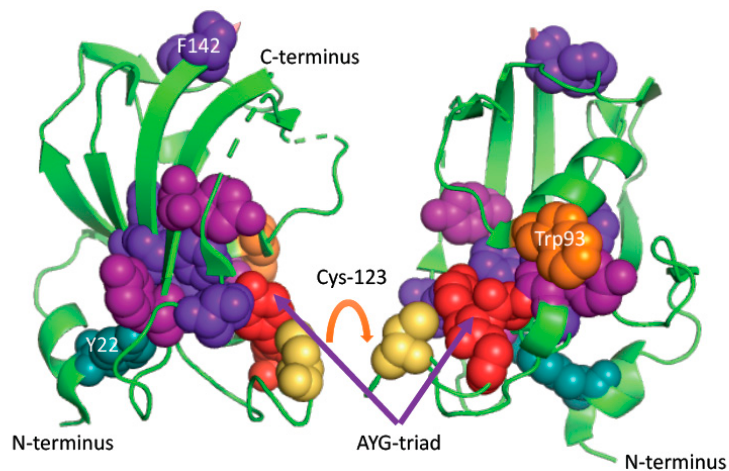
Figure 4. X-ray structure of the FKBD domain of hFKBP36. Cys123 (yellow) is surface-exposed and could form intramolecular disulfide bond and give rise to a dimer as shown by an arrow. Phe residues are in violet, Tyr are in forest color whereas highly conserved triad in the FKBPs (AYG and its variants) is a part of the long loop linking the C-terminusb b-strand with the rest of the molecule. It is in red as shown by an arrow.